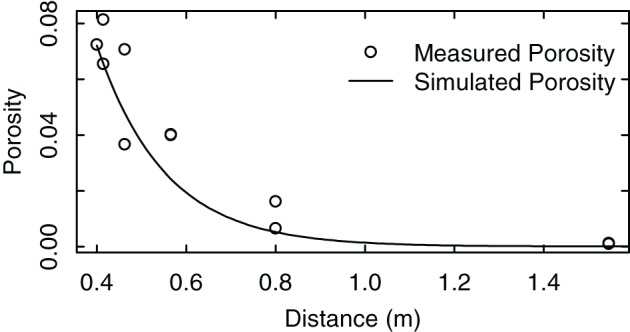
Measured porosity of a grapevine row trained to a VSP trellis. The distance equals the length a solar beam has to travel to traverse the foliage. The measurements were taken from RGB pictures of a vertical square of 0.70 m positioned in front of a vertical foliage wall. Pictures were taken from a distance of 5 m at different viewing angles along a horizontal semicircle.